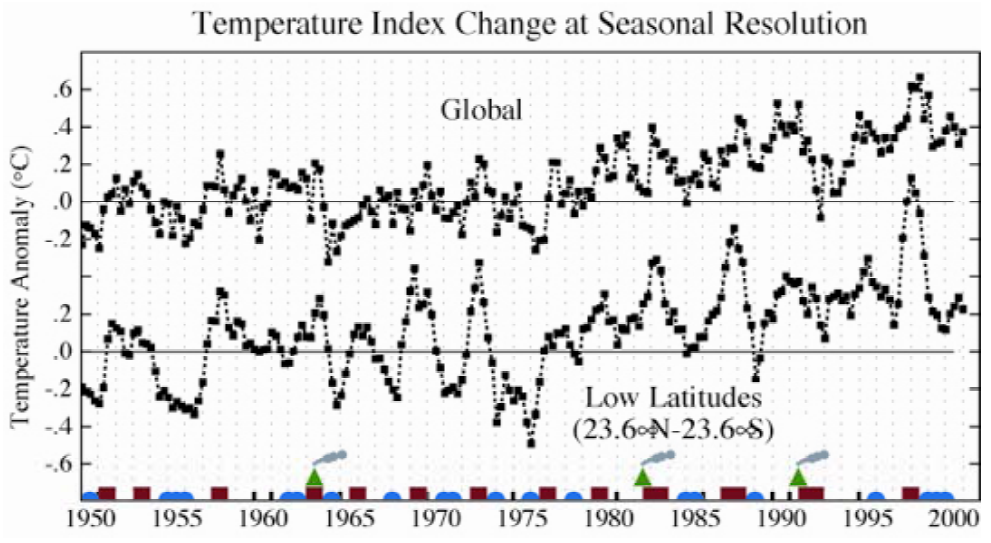
FIGURE 3. Global and tropical surface temperatures (1950–2000). Green triangles denote times of large volcanic eruptions; red squares-times of El Niños, and blue circles-times of La Niñas.